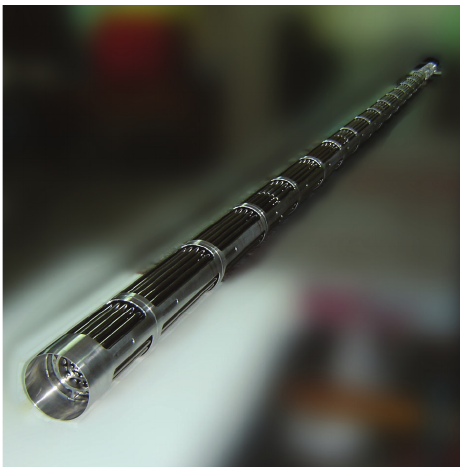
Figure 12: First prototype of a CARA fuel for the Atucha I